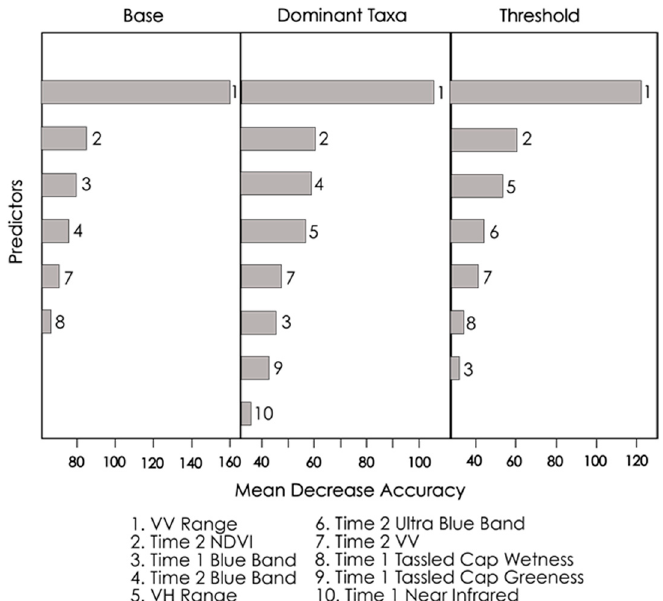
Figure 8. Top model predictor variables ranked by relative variable importance derived from the mean decrease in accuracy.